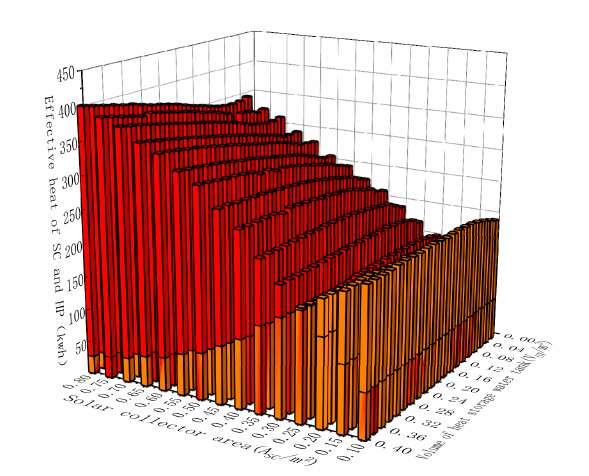
Figure 14. Diagram of the effective heat provided by the SC and HP as A SC and V ST change.